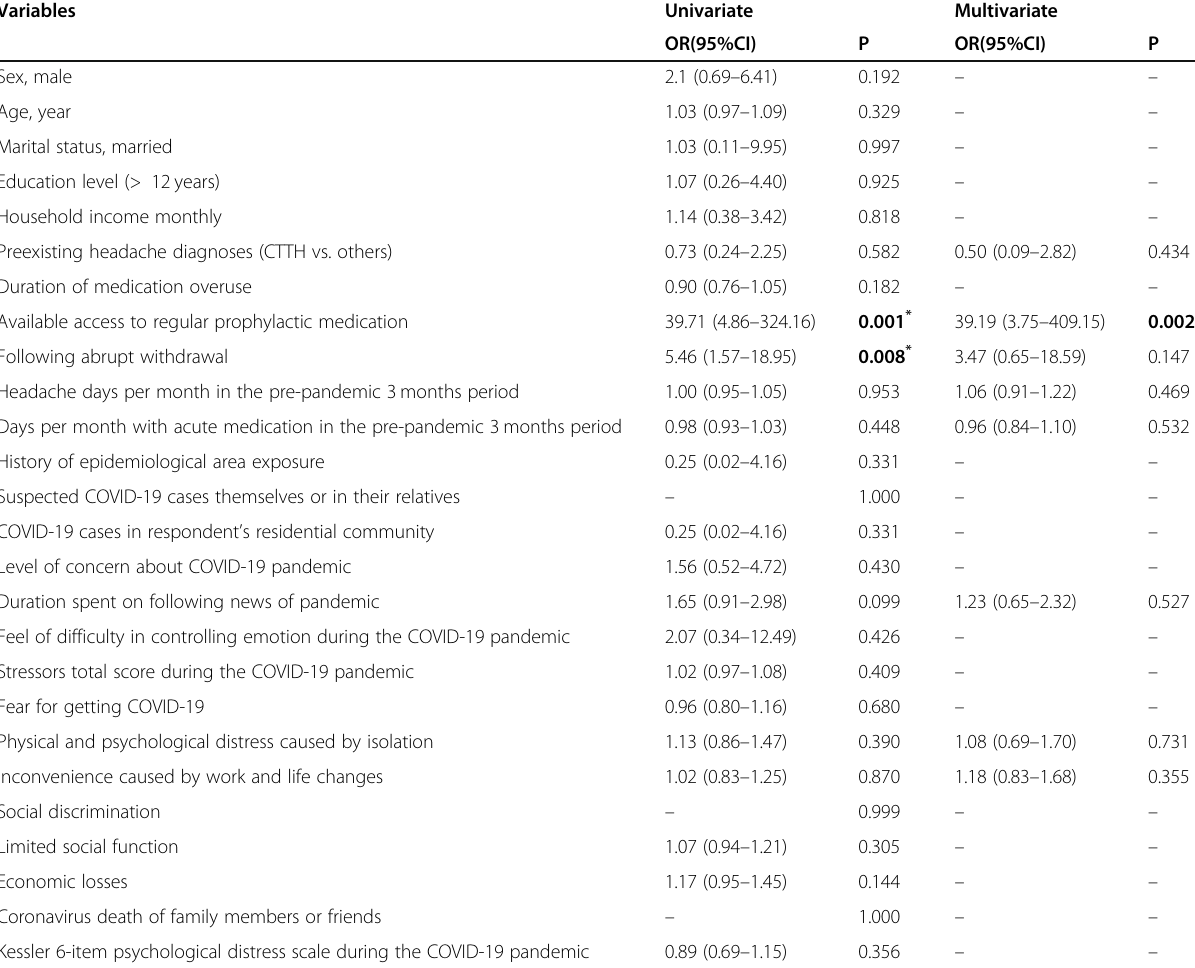
Table 3 Univariate and multivariate logistic analysis to identify independent variables reducing headache days ( ≥